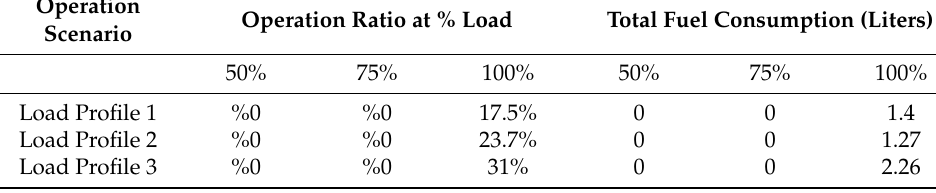
Table 4. DGen Fuel Consumption with